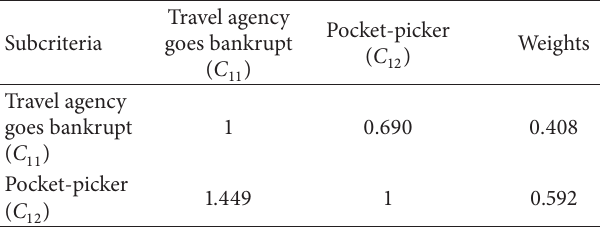
Table 3: Pairwise comparison matrices for criteria of level